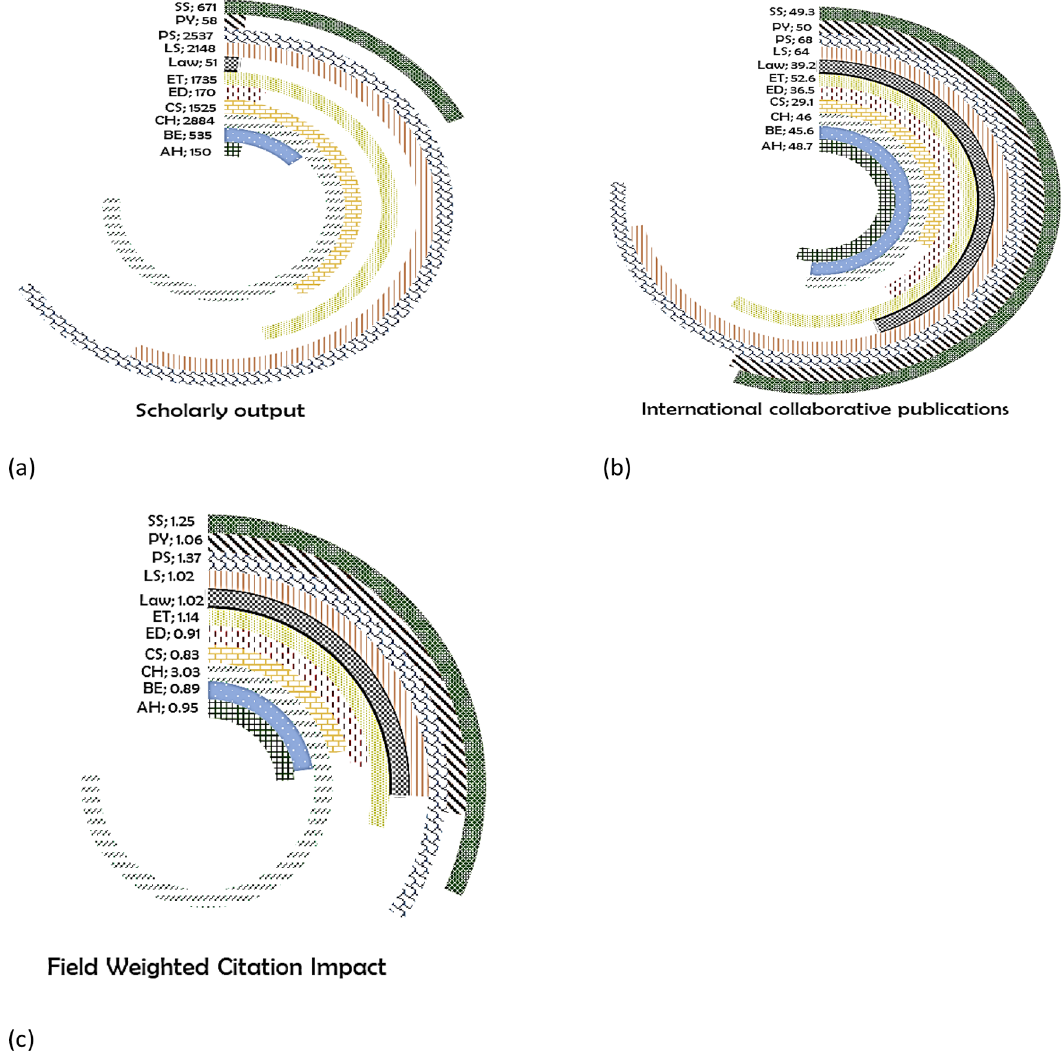
Figure 14. Subject wise split of Sri Lanka research outcome (a) scholarly output, (b) International collabora- tion and (c) FWCI. Arts & Humanities (AH), Business and Economics (BE), Clinical, pre-clinical and health (CH), Computer Science (CS), Education (ED), Engineering and Technology (ET), Life Science (LS), Physical Science (PS), Psychology (PY), Social Science